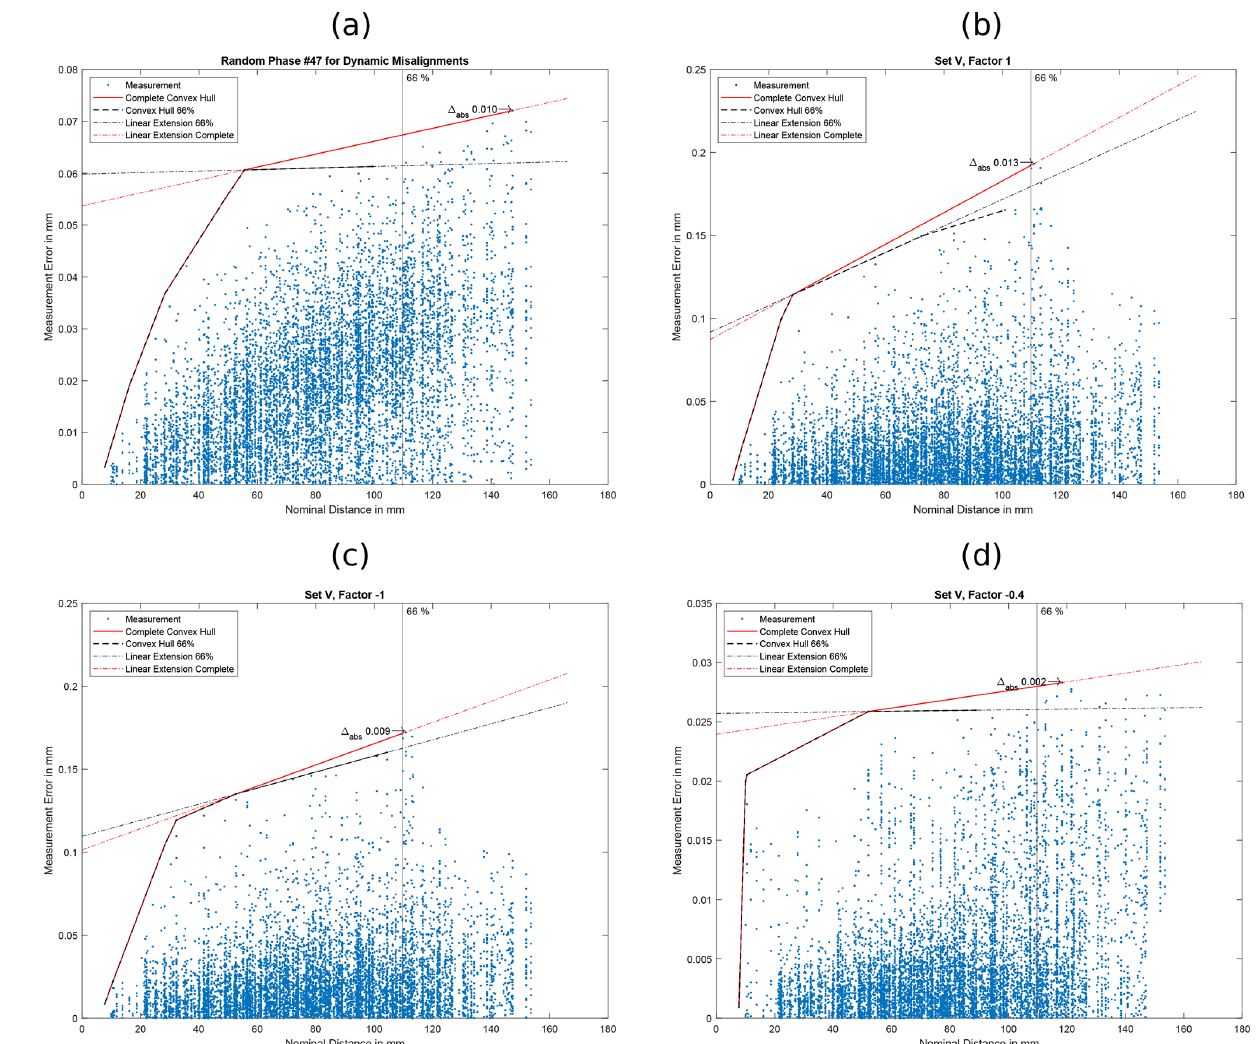
Figure 12. Convex hull analysis of non-linearity: the plots show the data points, both convex hulls (using points until 66% and using all points) as well as derived MPE specifications. The (cid:49) abs marks the data point with the largest distance to the 66% MPE specification. The plot (a) is the last one for the simulations for the five random phase angles from Sect. 4.3 and part of simulation set II (for the first four,